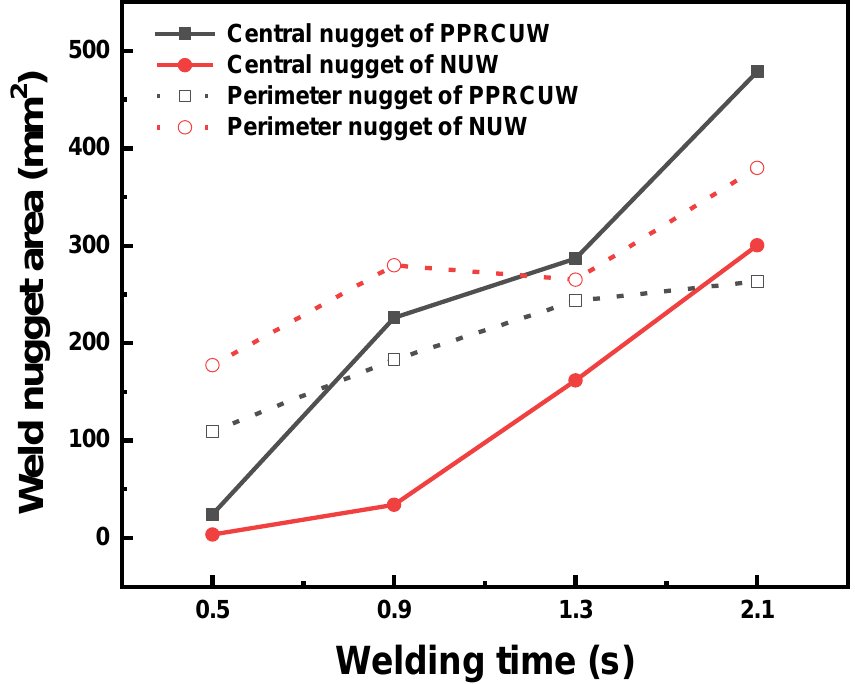
Figure 10. Effects of welding time on weld nugget size of NUW and PPRCUW joints.